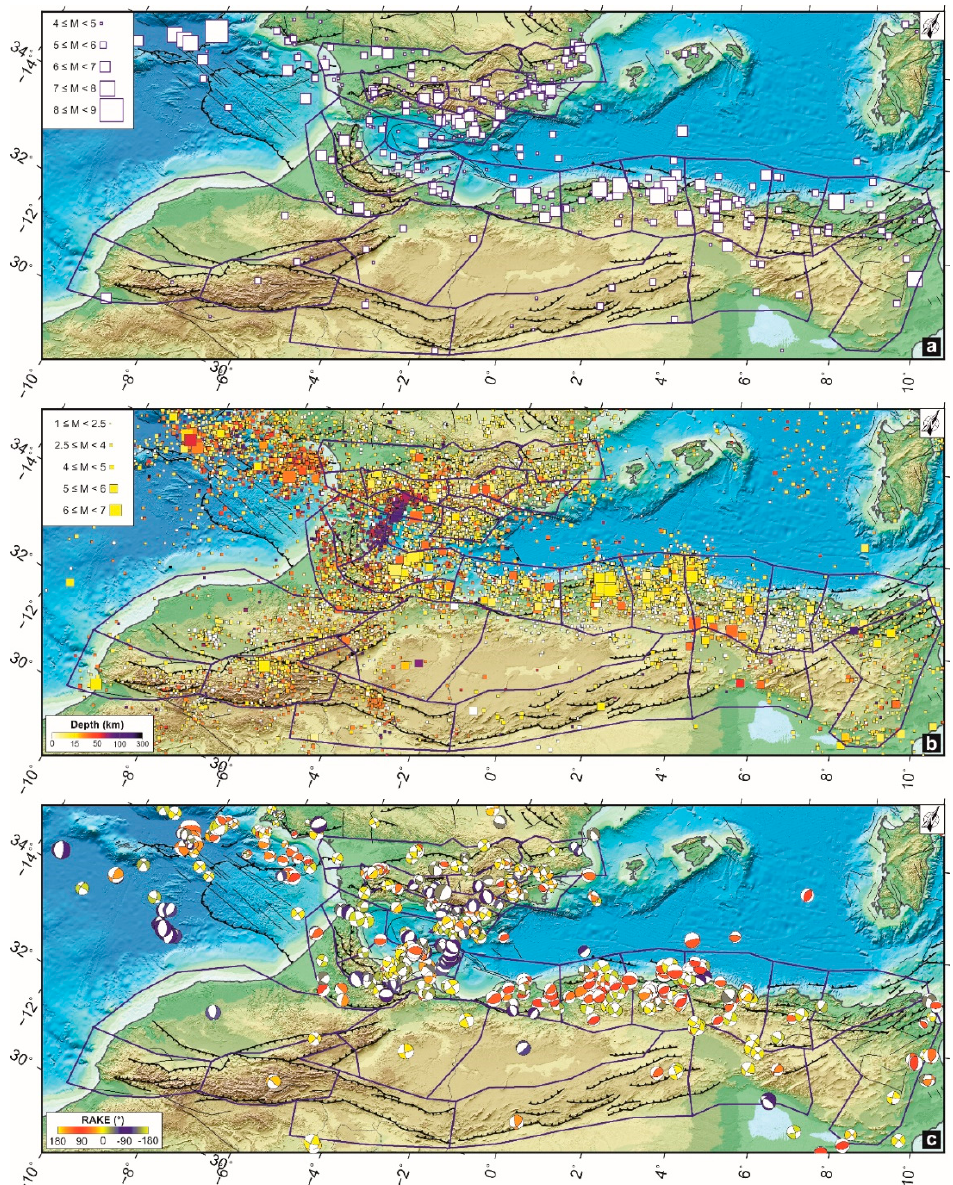
Figure 2. ( a ) Historical earthquakes (blue squares; M ≥ 4.0) occurring during AD 856–1950 [36–38]. ( b ) Instrumental crustal seismicity (M ≥ 2.5) occurring in the investigated area since 1910 [46]. Symbols are colored according to focal depth. ( c ) Lower hemisphere, equal area projection for fault plane solutions (with M ≥ 3) compiled from the investigated area [23,47–49]; fault plane solutions are colored according to rake: red indicates pure thrust faulting, blue is pure normal faulting, and yellow is strike-slip